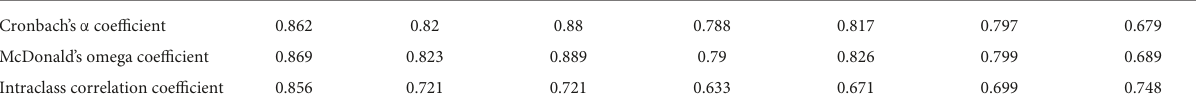
TABLE 4 Reliability analysis of the